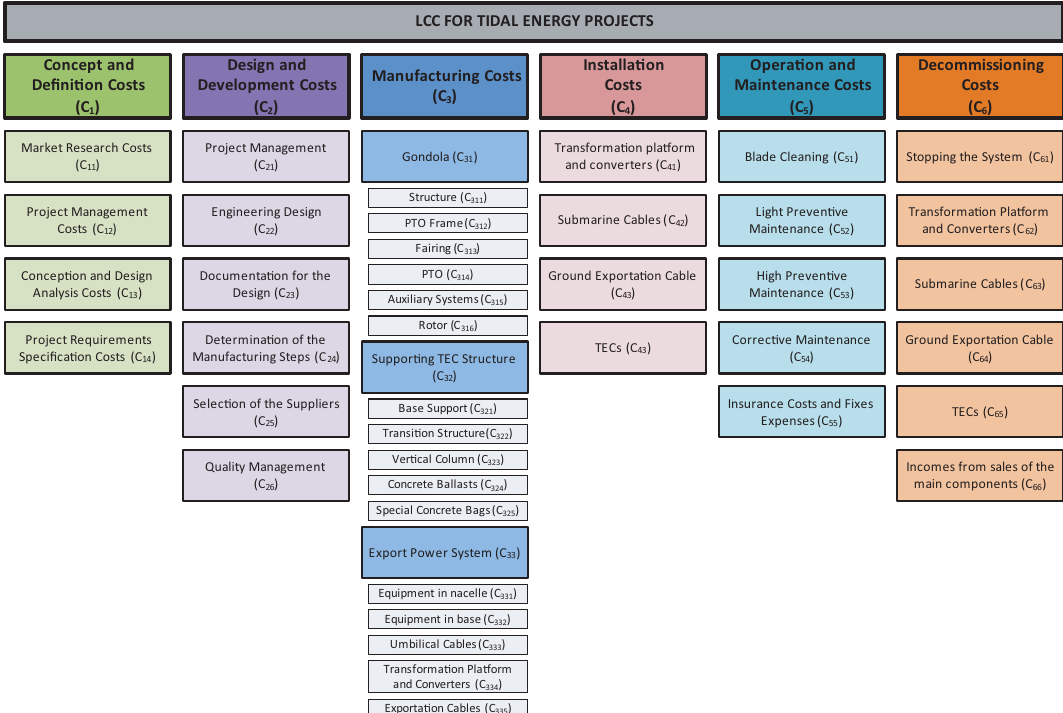
Figure 12. Life cycle costs for tidal energy projects composed of gravity-based first generation